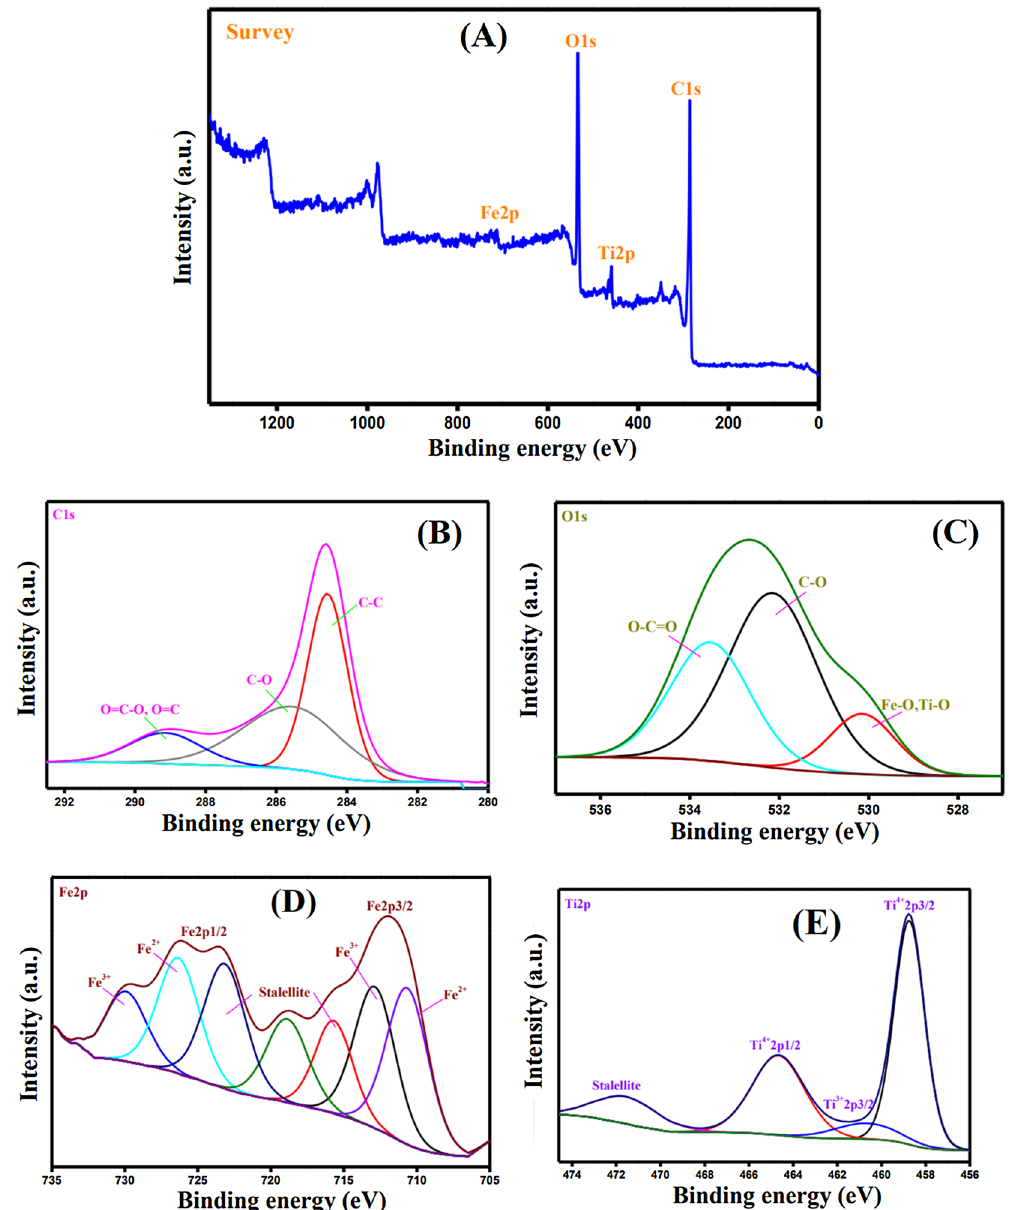
Figure 5. XPS spectra ( A ) wide scan, ( B ) C1s, ( C ) O1s, ( D ) Fe2p, and ( E ) Ti2p of MIL-125(Ti)/MIL-53(Fe)/ CNT@Alg composite